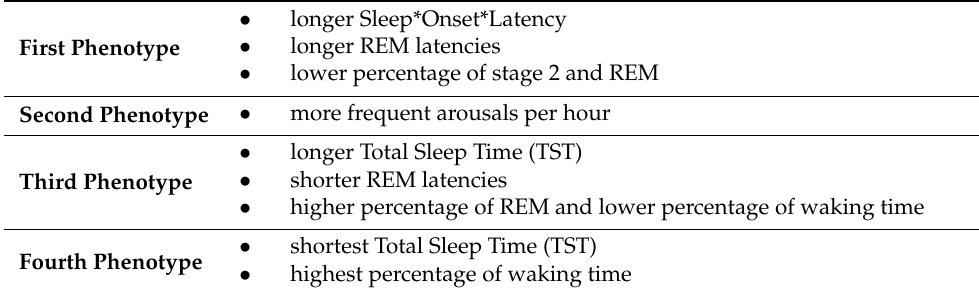
Table 1. Sleep-specific phenotypes of fatigue (according to Reference